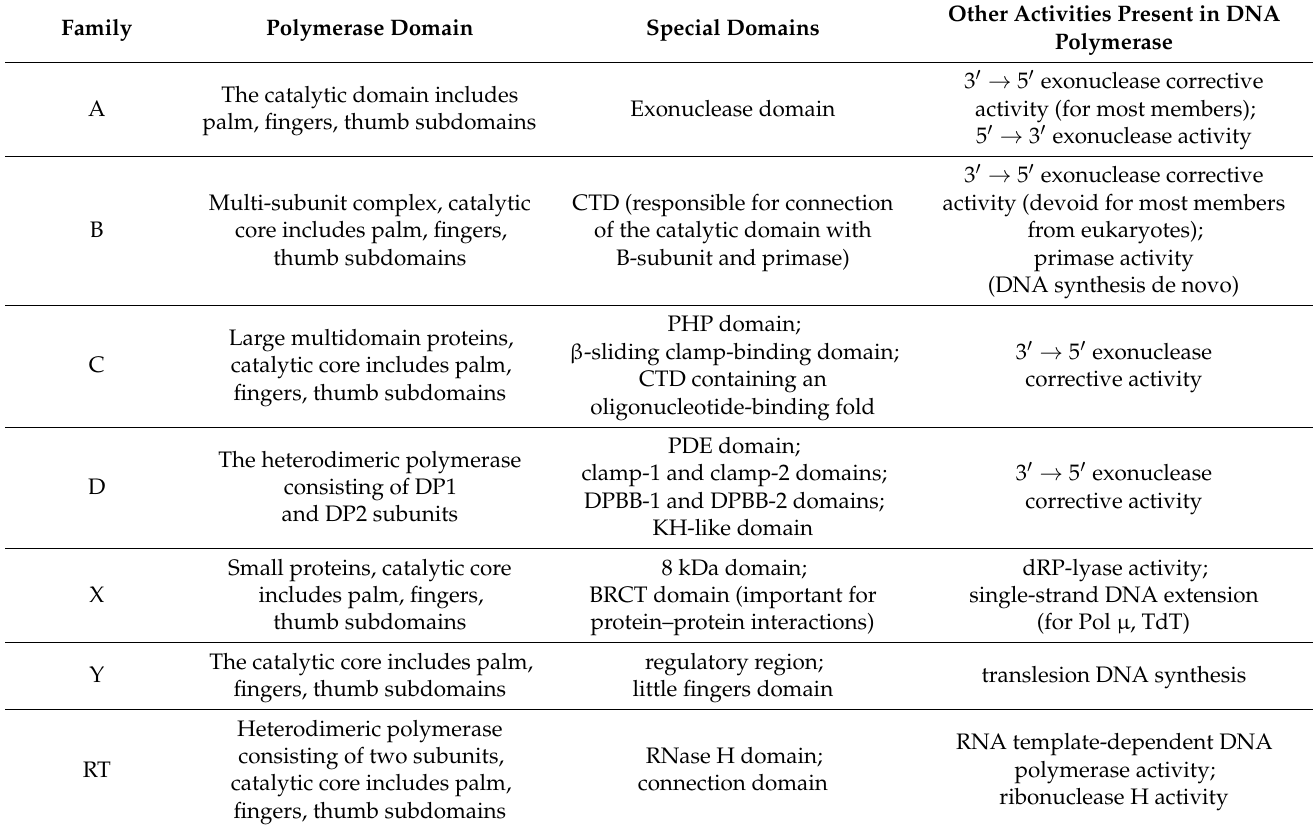
Table 2. The differences and similarities between DNA polymerase